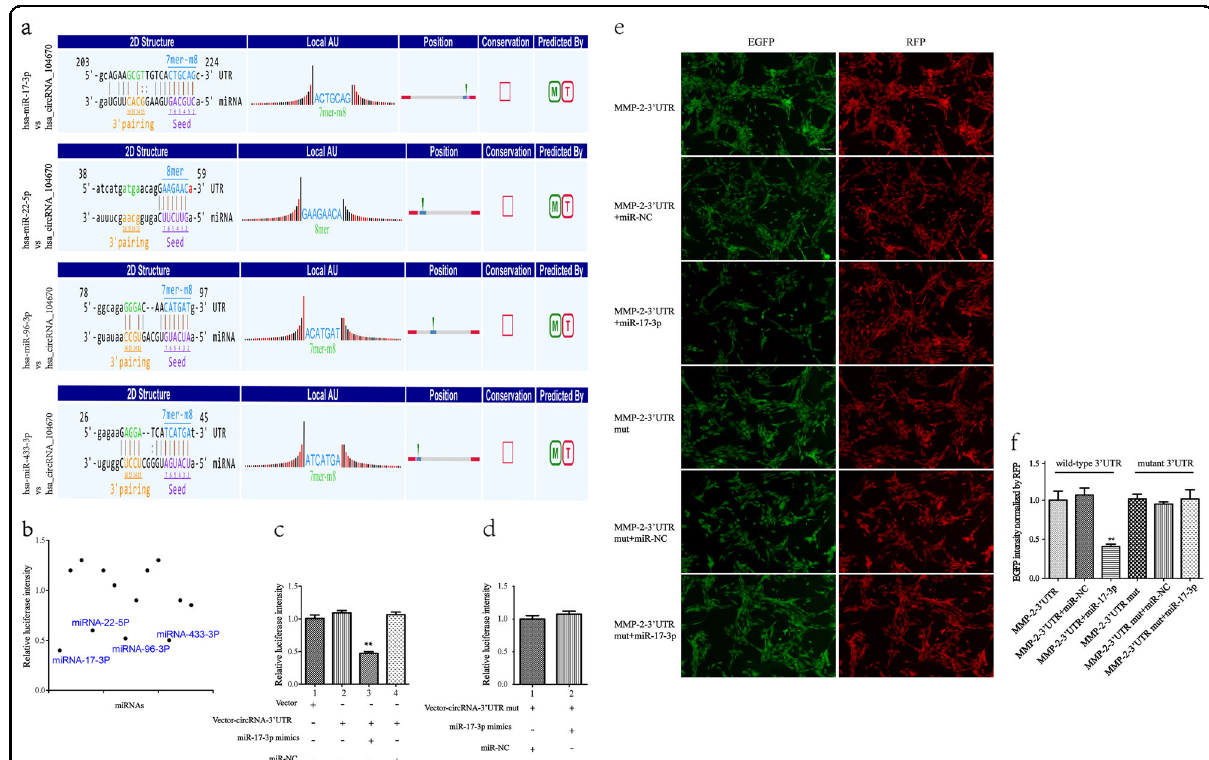
Fig. 3 CircRNA 104670 serves as a sponge for the miR-17-3p and MMP-2 is directly targeted by miR-17-3p. a The binding region of miRNAs in circRNA_104670 3 ′ UTR are shown. b A luciferase reporter assay con fi rmed that miR-17-3p, miR-22-5p, miR-96-3p, and miR-433-3p reduce